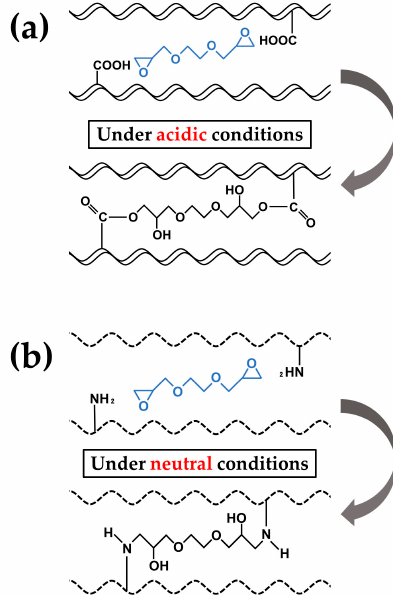
Figure 13. Schematic of cross-linking reactions of ( a ) HLA with EGDE using -COOH groups at pH = 4, and ( b ) AG with EGDE using NH 2 groups at pH = 7.